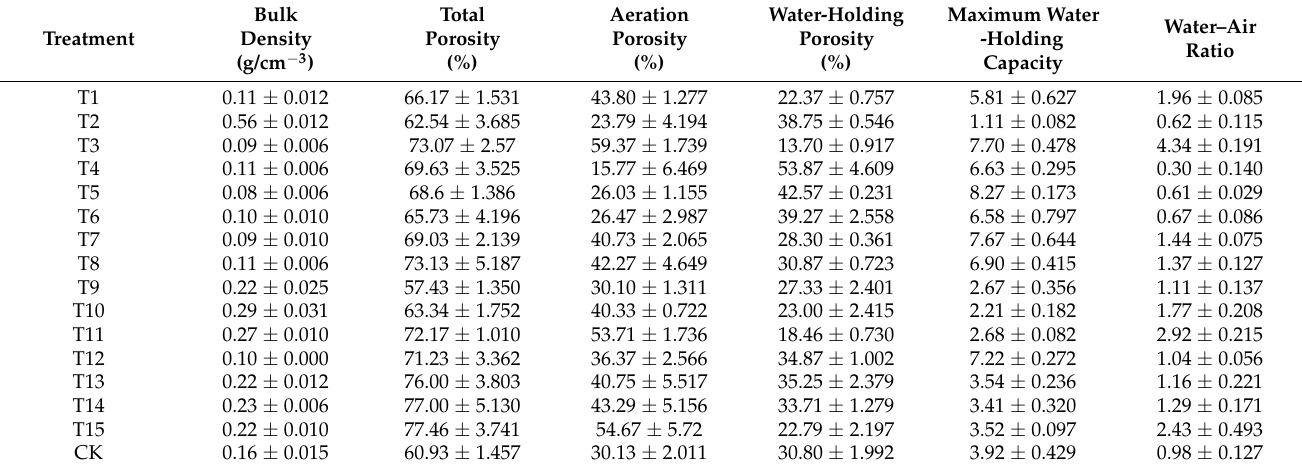
Table 3. Physical characteristics of H. chrysanthus in different mixed